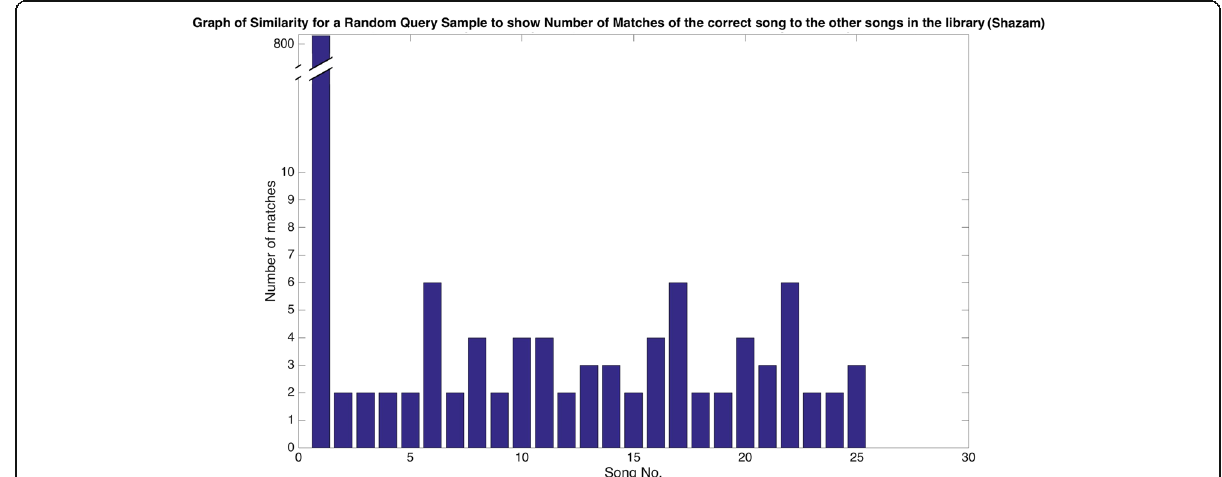
Fig. 7 Test for similarity of unknown sample to songs in the database (Shazam). In this figure, it was seen that a random 20-s sample clip was taken from a song in the database and was queried using the Shazam algorithm. This test was done to show and compare the number of matches the query had to each song in the library. Results showed that the number of matches for the corresponding song was large compared to the matches of the query found in other songs in the database. This justified the reliability of the Shazam